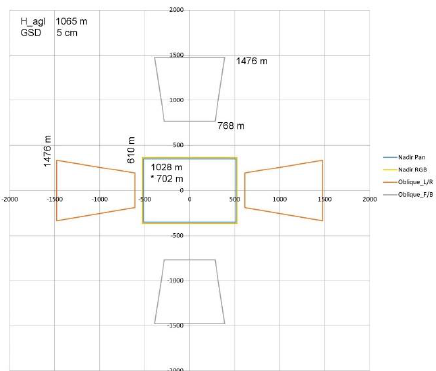
Figure 1b: Footprint of UltraCam Osprey 4.1. The oblique camera heads are inclined by 45°.